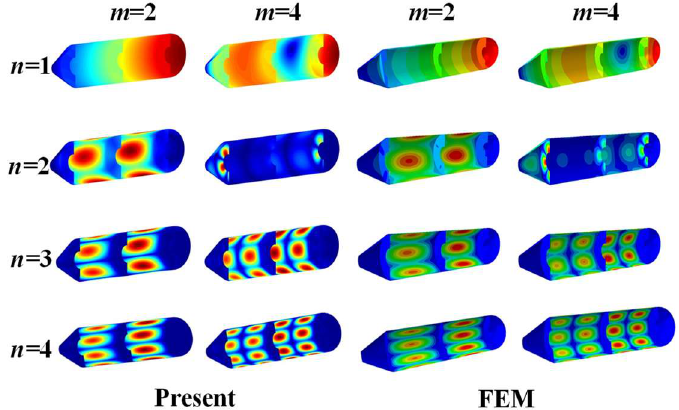
Figure 4. Comparison of modal shapes obtained using the two methods.